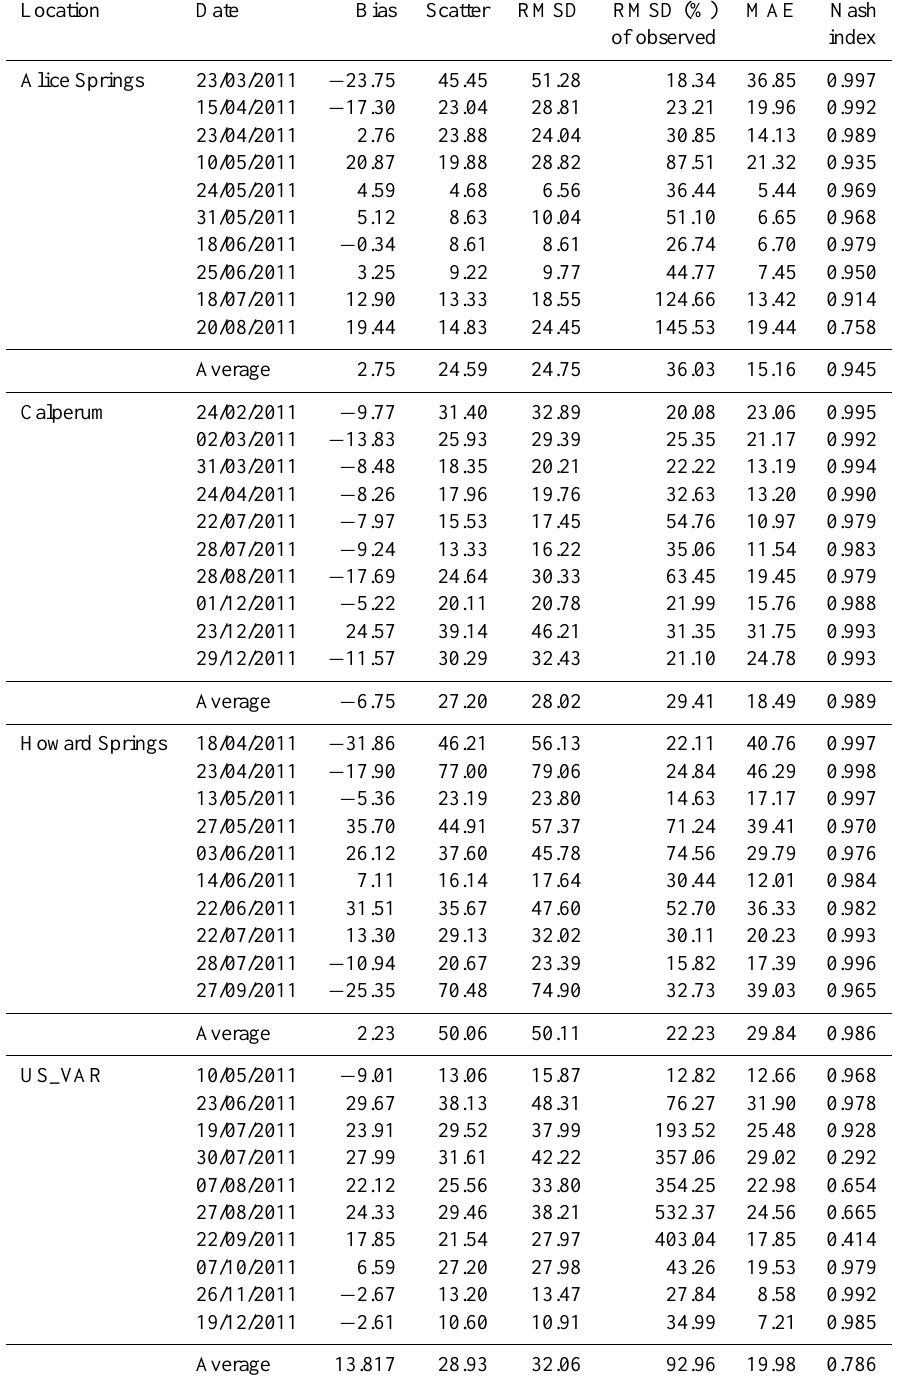
Table 5. Daily simulation accuracy and average site simulation accuracy for LE fluxes. Bias, scatter, RMSD and MAE are expressed in Wm − 2 . Nash index is